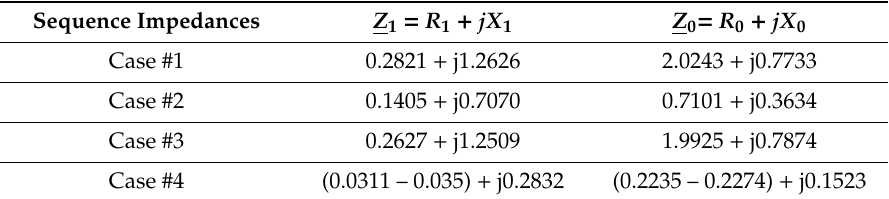
Table 10. Positive and zero sequence impedances in Ω with